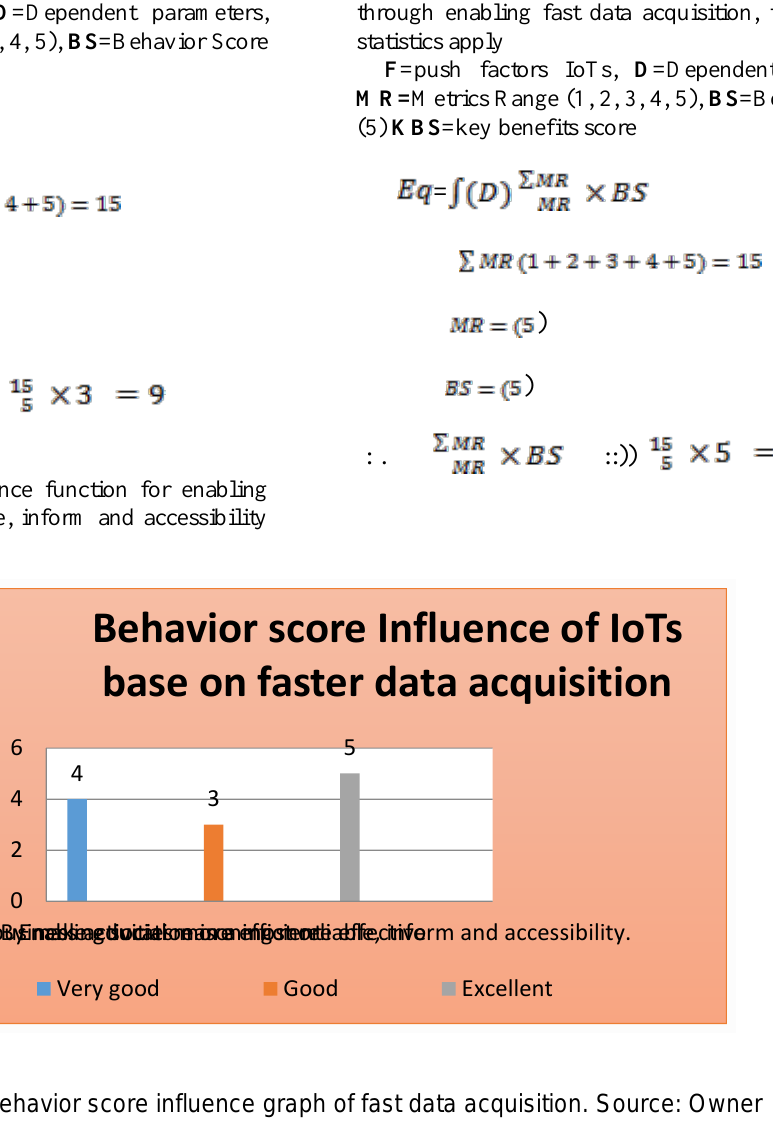
Figure 12. behavior score influence graph of fast data acquisition. Source: